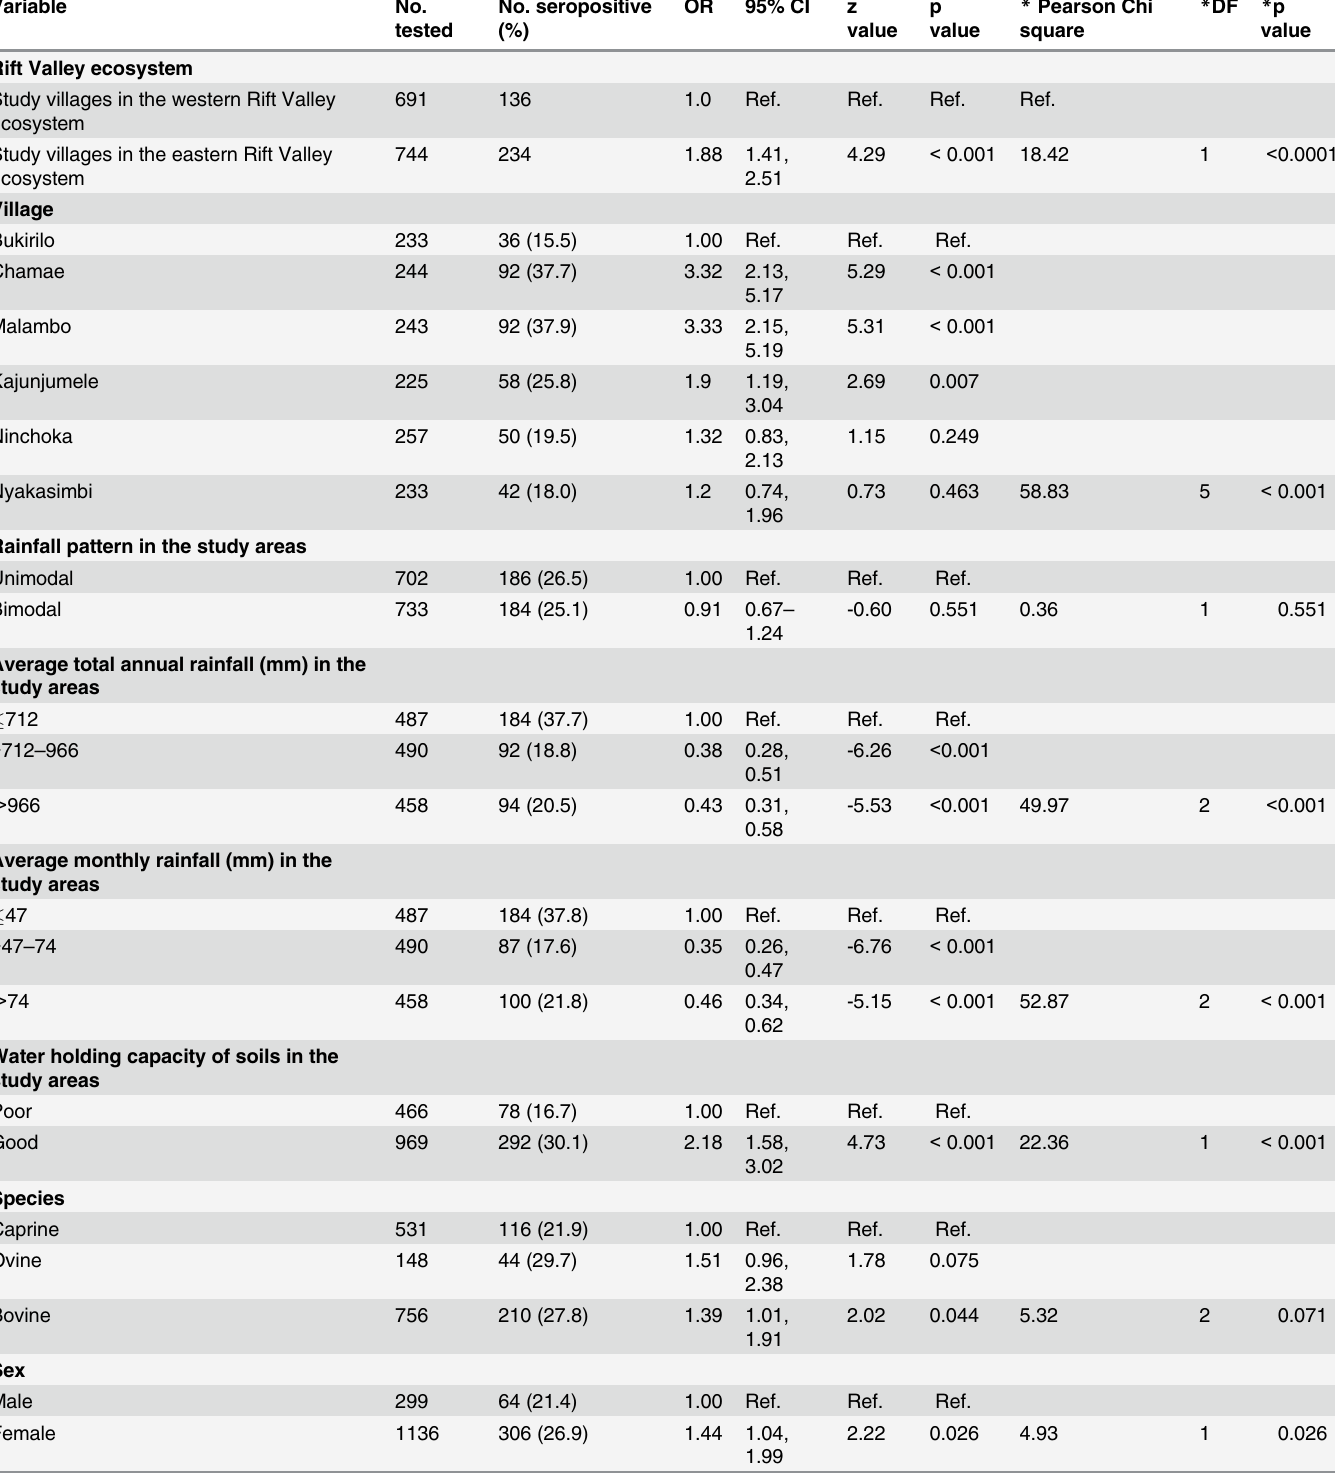
Table 3. Univariable mixed effects logistic regression analysis of risk factors associated with Rift Valley fever seropositivity in domestic rumi- nants (herd was included as random effect variable). Variable No.